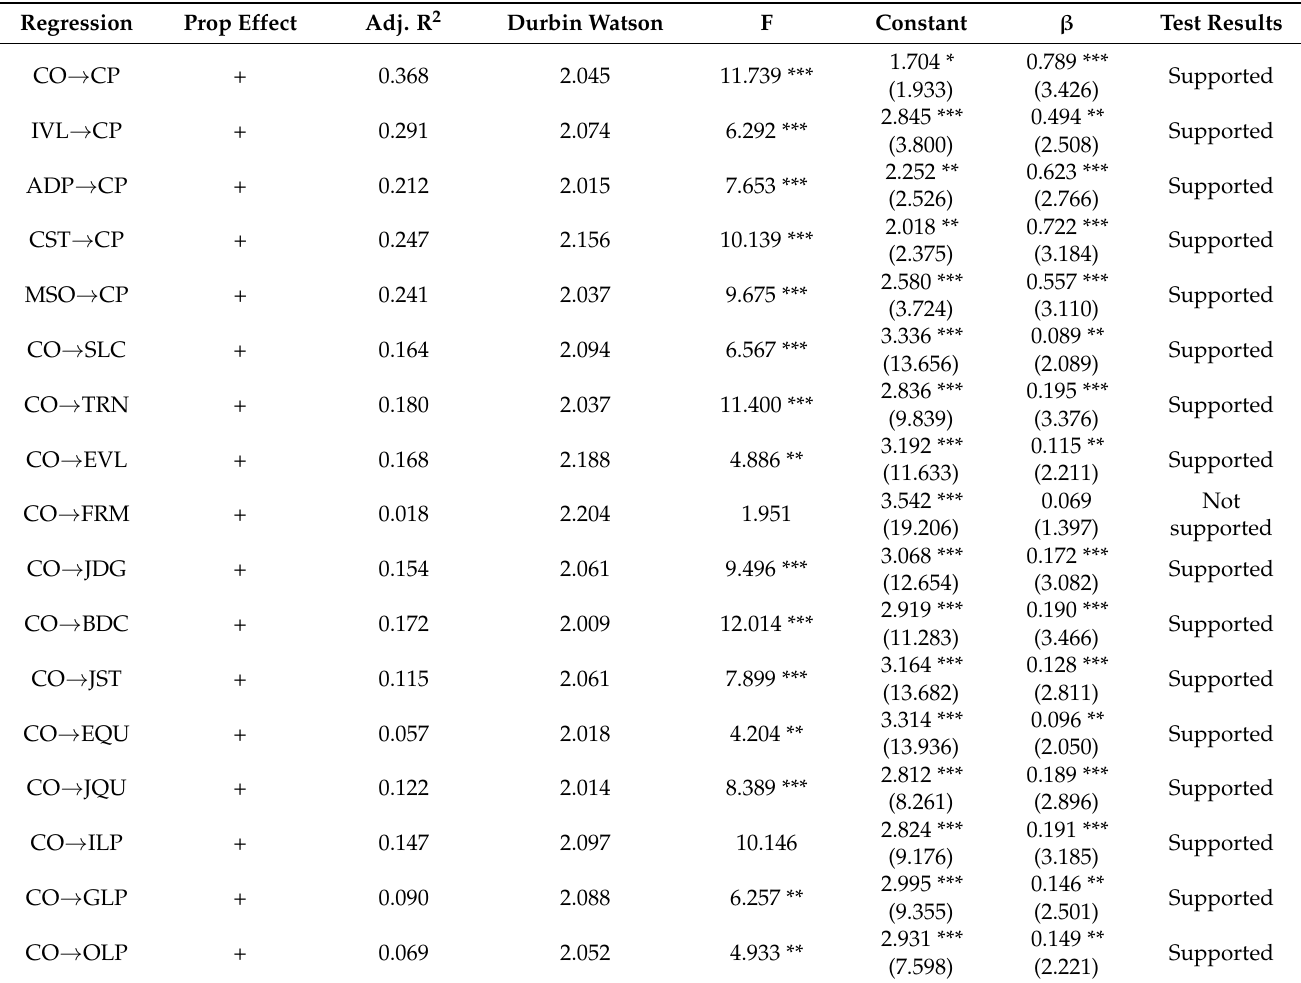
Table 4. Multiple regression